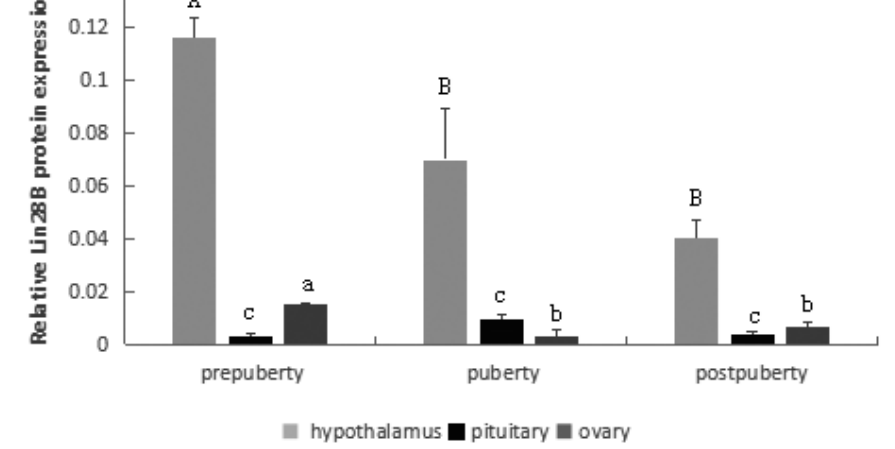
Figure 5. LIN28B relative protein levels in the hypothalamus, pituitary and ovary. Different letters above the bars in the same tissue indicate significant differences (p<0.05). LIN28B, lin-28 homolog